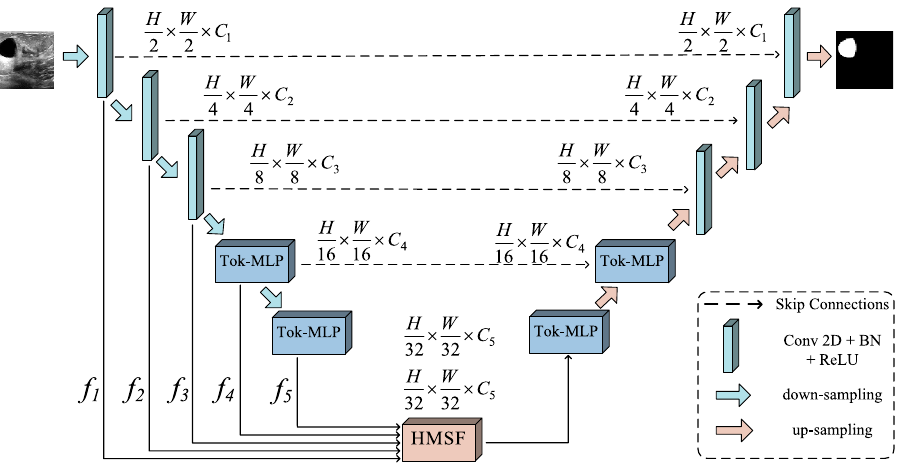
Figure 1. Overall architecture of the DHMF-MLP (created by ‘Microsoft Office Visio 2013’ URL: https:// www. micro soft. com/ zh- cn/ micro soft- 365/ previ ous- versi ons/ micro soft- vision-